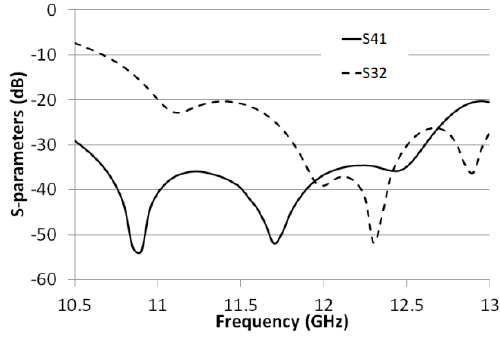
Figure 16. Experimental isolation of the single-layer Magic Tee prototype shown in Figure 14.